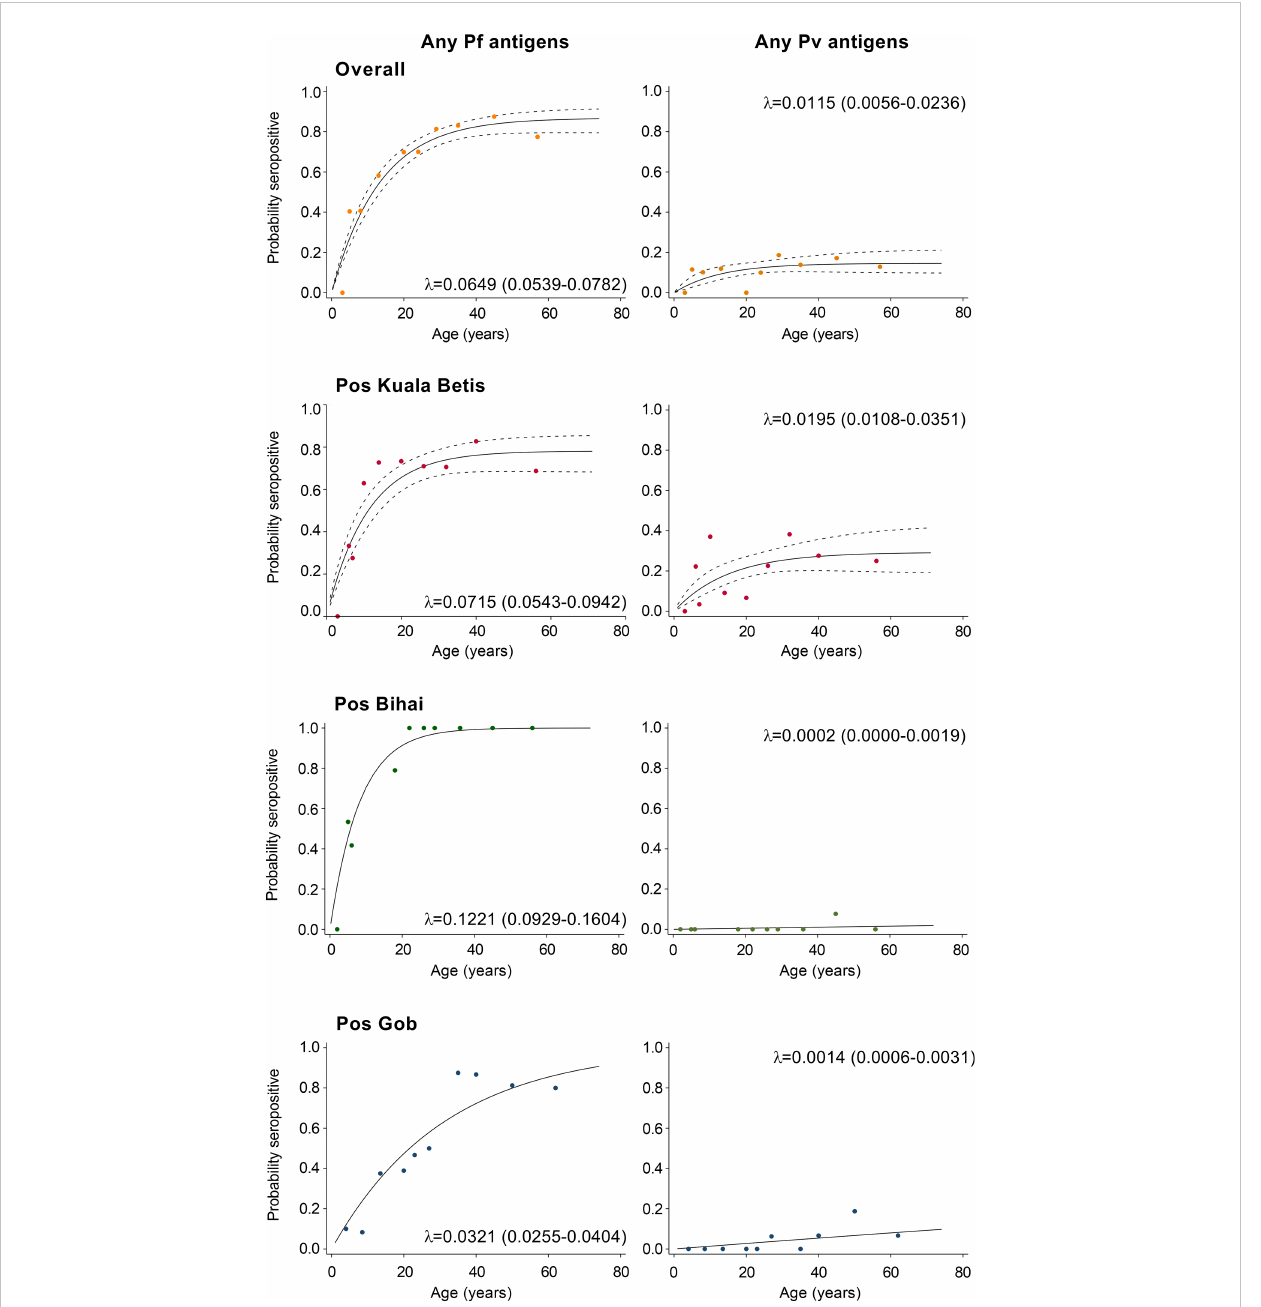
FIGURE 4 Annual probability of malaria seroconversion rate in Gua Musang district, Kelantan state. P. falciparum - and P. vivax -speci fi c antigens by age in each setting. Points indicated observed seroprevalence, and solid lines show model-predicted seroprevalence. The broken line represents 95% con fi dence intervals. Seroconversion rates (SCRs; l ) are presented on the